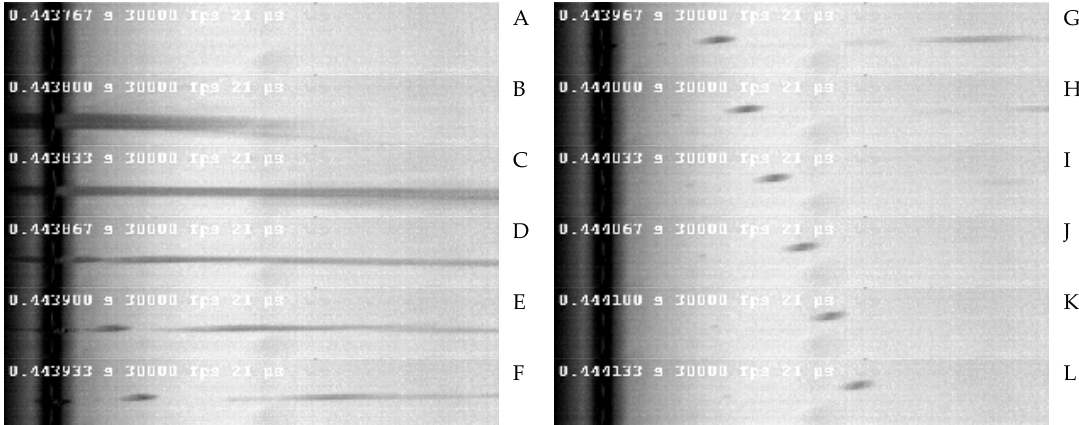
Figure 12. High-speed images of REPDTP-R-SiO drop formation with a time-interval of 33 µs between frames. Left from top to down: Frames 1 to 6. Right from top to down: Frames 7 to 12.